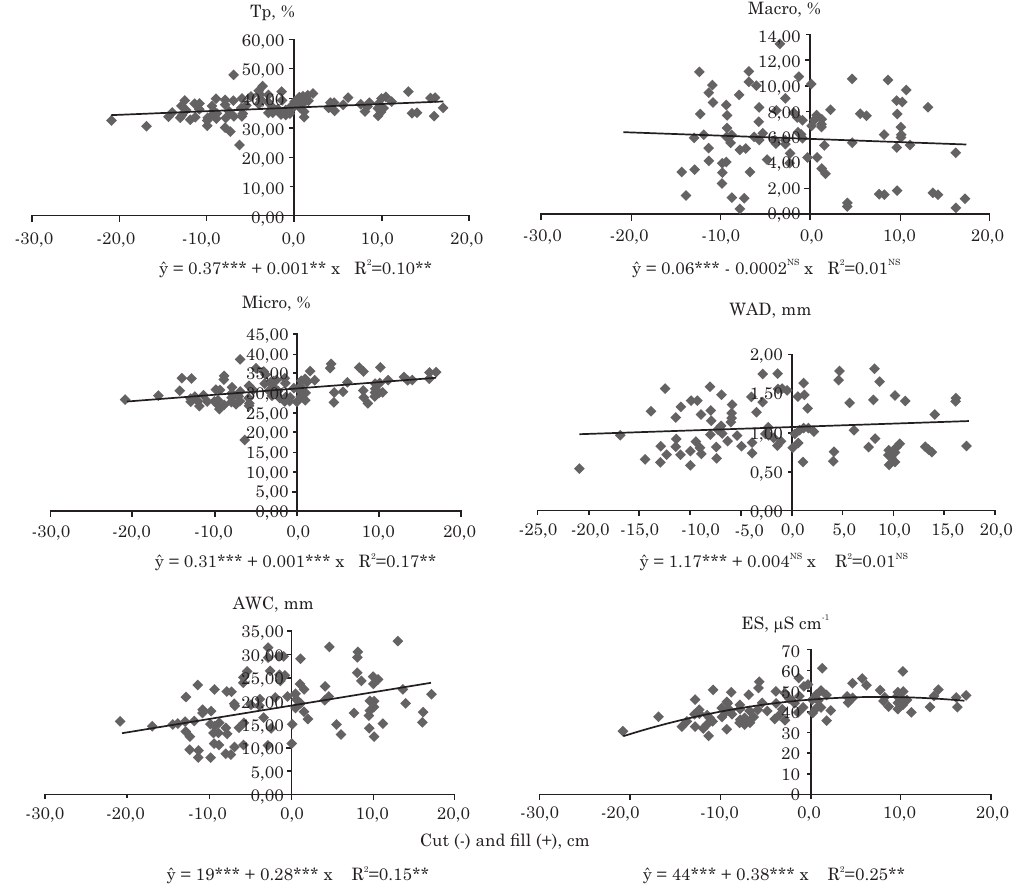
Figure 6. Regressions between cut (-) and fill (+) depths and total porosity (Tp), macroporosity (Macro), microporosity (Micro), weighted average diameter (WAD), available water capacity (AWC) and electrical conductivity (EC). *** p<0.001; ** p<0.01; * p<0.05 and NS not